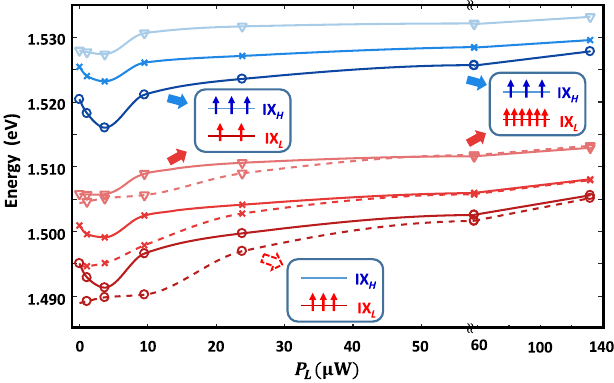
FIG. 5. IX resonance energies as a function of the G L excitation power recorded for a constant G H power density of 3 . 6 W = cm 2 . The symbols correspond to electric fields of 19 (triangles), 25.3 (crosses), and 28 . 5 kV = cm (circles) applied in reverse bias across sample B . The solid lines are recorded in the presence of both the IX H and IX L clouds, while the dashed lines show the IX L ’ s energies detected in the absence of the IX H cloud. The lines connecting the measurements (symbols) are spline